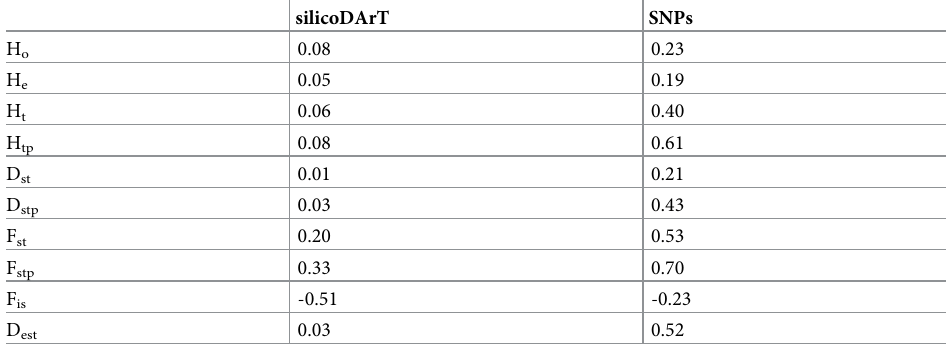
Table 1. Genetic diversity of T . orientalis based on silicoDArT and SNP markers. Estimates with p indicate that these are corrected e.g. corrected Fst = Fstp.